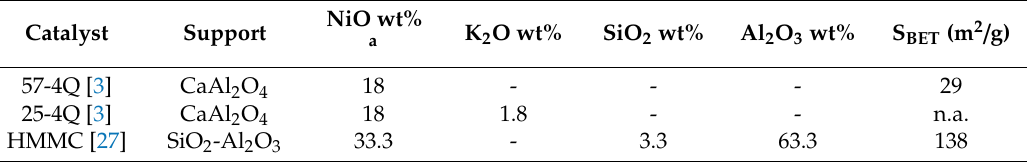
Table 2. Compositions of the catalysts tested in this